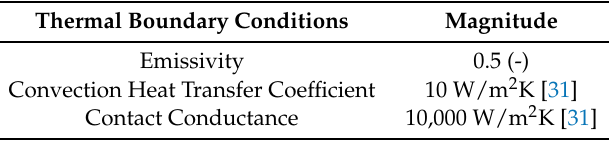
Table 5. Thermal boundary conditions.